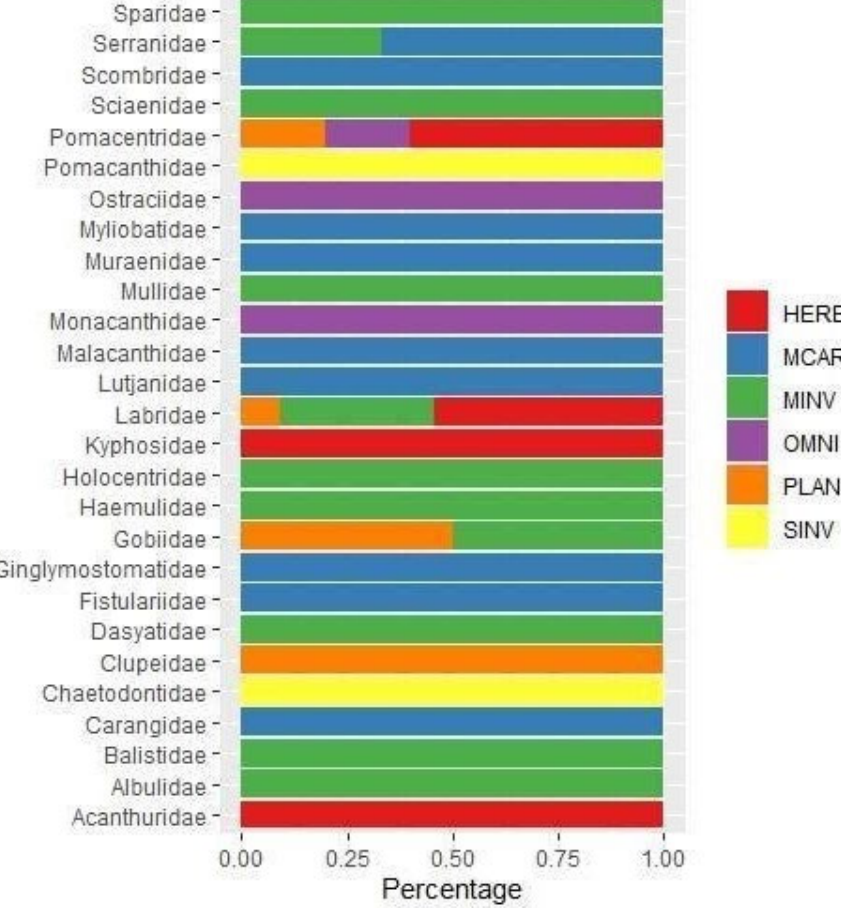
Figure 9. Trophic composition (%) by family in the mesophotic zone of Marine Protected Area Costa dos Corais, Brazil.